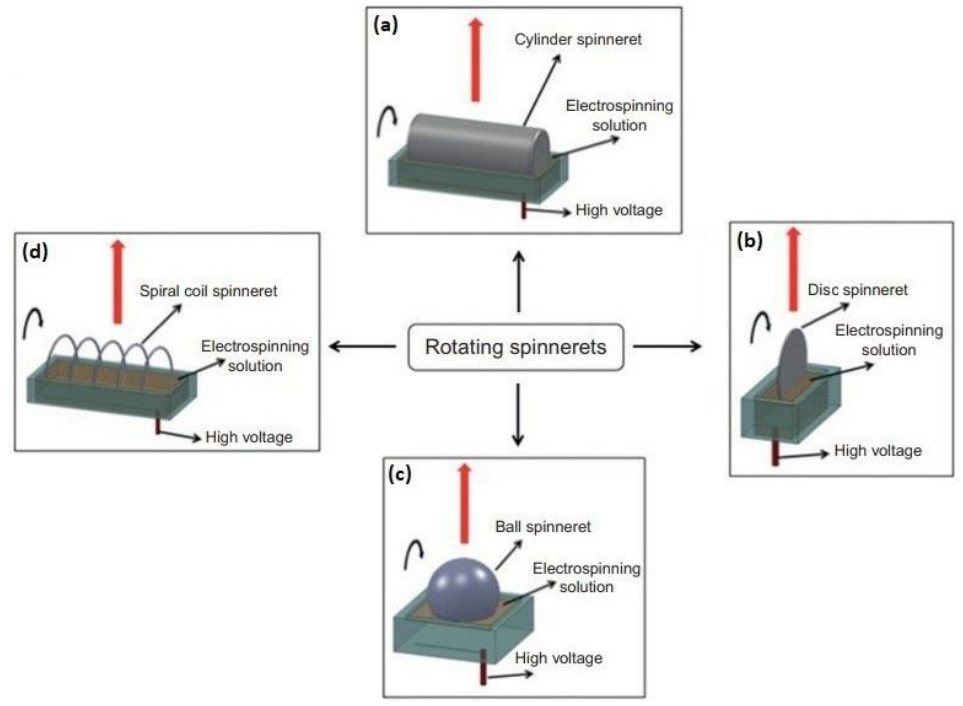
Figure 3. Schematic diagram depicting the rotating spinnerets: ( a ) cylinder spinneret, ( b ) disc spinneret, ( c ) ball spinneret and ( d ) wire/coil spinneret in needleless electrospinning (electrospinning direction along the red arrow). Adapted with permission (CC BY 3.0) from [39] .